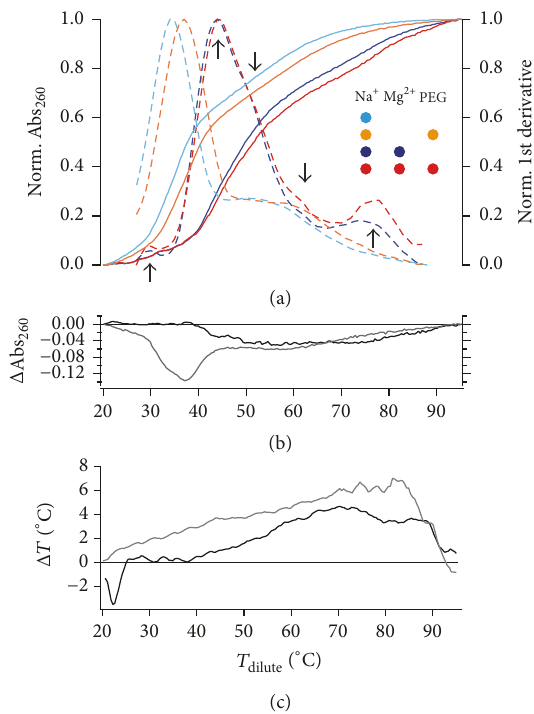
Figure 1: (a) Normalized thermal UV-denaturation profiles of the RPS12 pre-mRNA from Trypanosoma brucei (colored, solid lines) at different buffered solvent conditions. Red/orange: crowded solvent conditions (6% (w/w) PEG 4000 ). Blue/cyan: dilute solvent conditions. Dark colors: 2 mM Mg 2+ . Bright colors: no Mg 2+ . Dashedtraces:normalized1stderivatives( 𝛿𝐴 260 /𝛿𝑇 )ofthedifferent melting profiles. Five helix-coil transitions are marked with arrows. (b) Difference ( Δ ) UV-melting profiles (dilute minus crowded conditions) in the presence/absence of Mg 2+ -cations (black/grey). (c) Shifting of the UV-denaturation profiles to higher temperatures expressed as Δ𝑇 versus 𝑇 of the dilute condition in presence/absence of Mg 2+ -cations